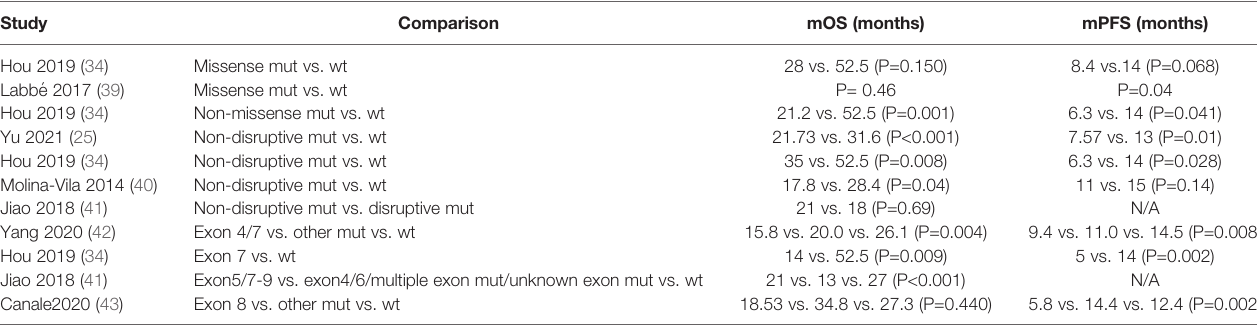
TABLE 3 | OS and PFS in different types of TP53 mutation in EGFR-mutated NSCLC patients. Study